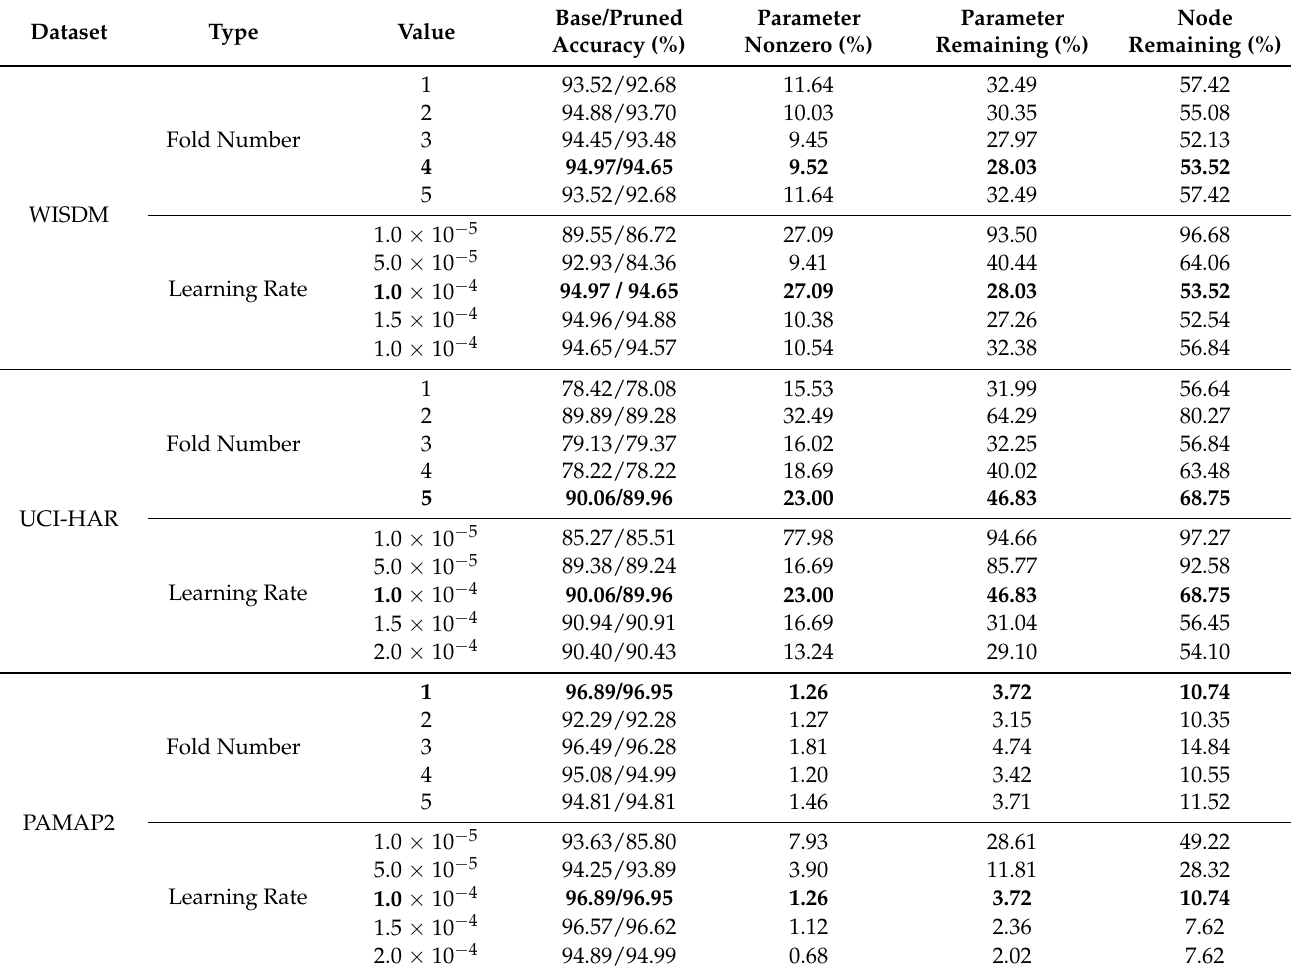
Table A9. Impact of different cross-validation fold numbers and learning rates on the proposed (cid:96) 0 sparse group lasso approach on each HAR dataset—WISDM, UCI-HAR, and PAMAP2, respectively. (We highlight our selection in both fold number and learning rate for each